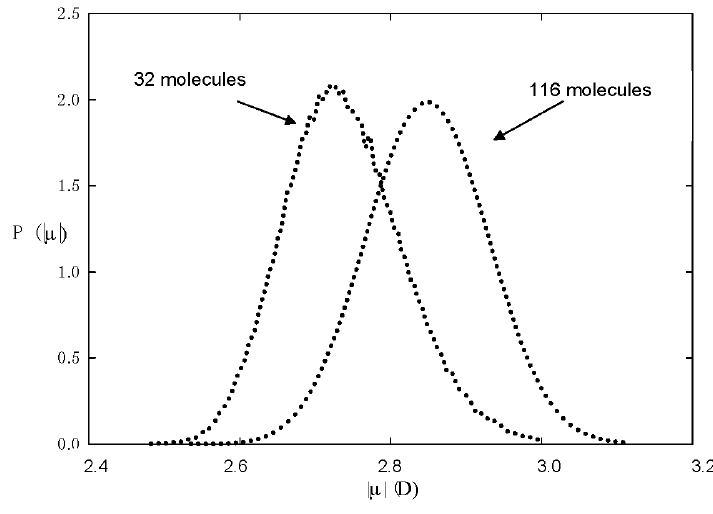
Figure 3. Probability distribution of the molecular dipole moment for DRSLL liquid water at 298 K, for the smallest (32-molecule) system on the left and the largest (116-molecule) on the